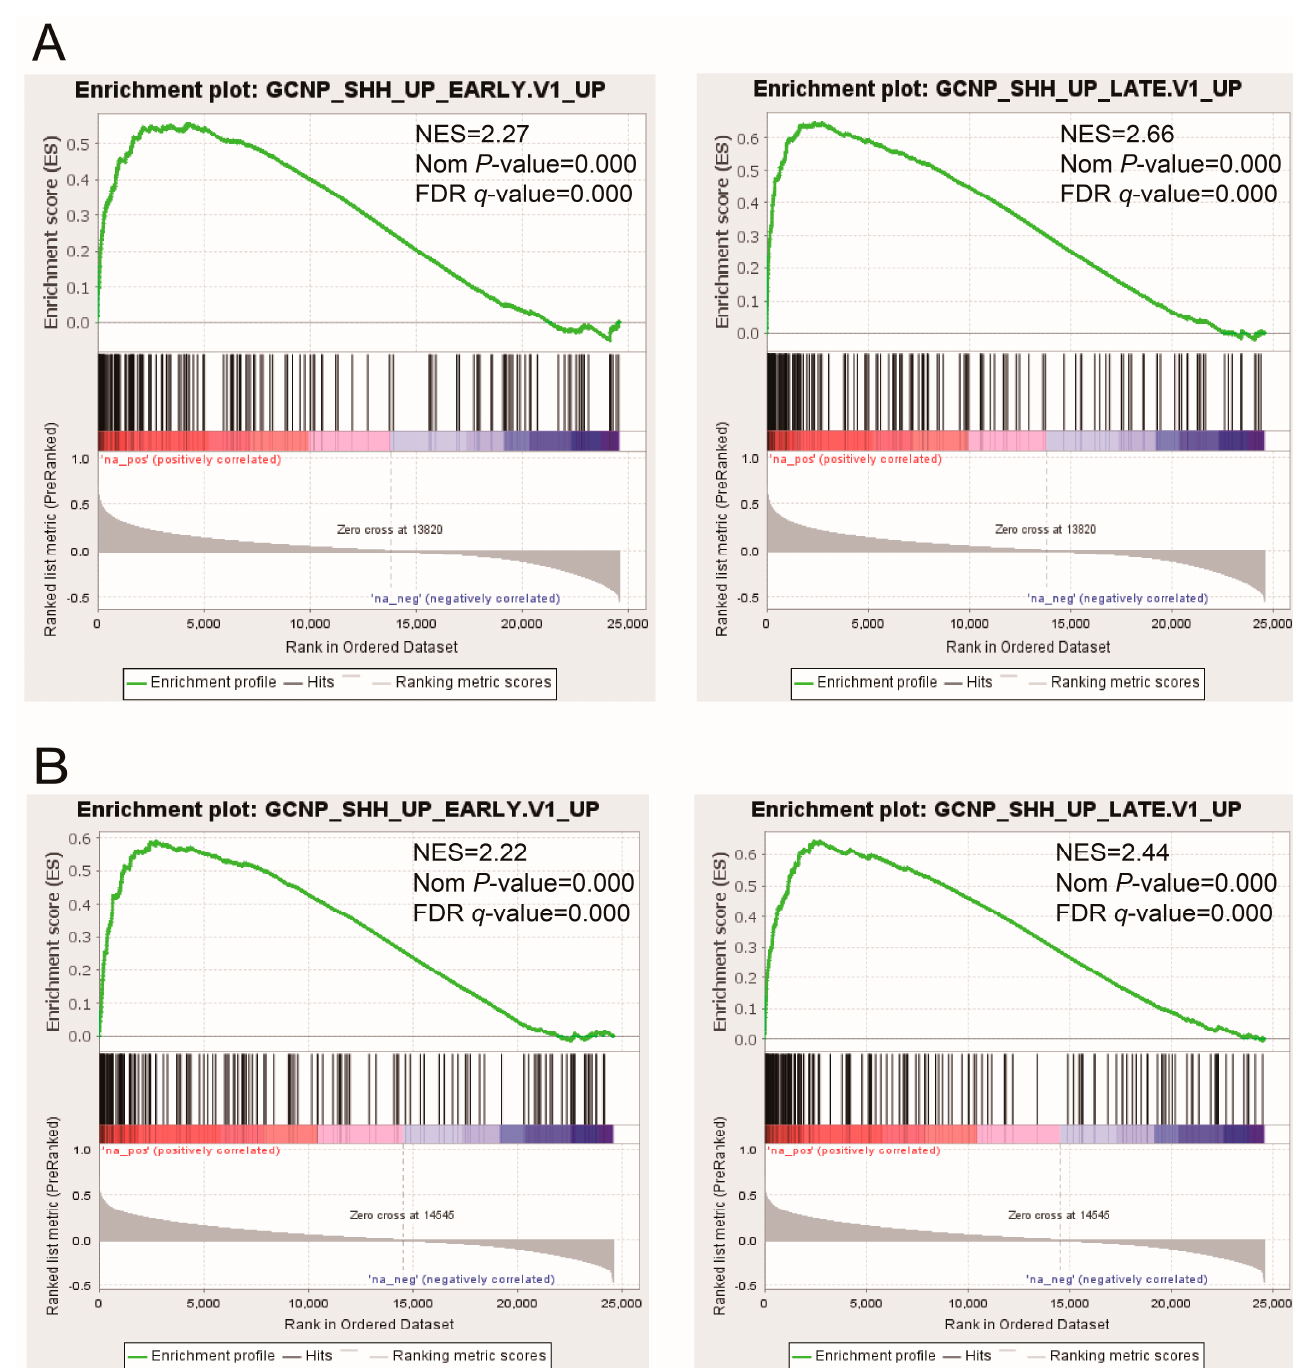
Figure 2. GSEA of the PRR11-SKA2 correlated gene set in the LSCC cohort of TCGA. ‘GCNP_SHH_UP_EARLY.V1_UP’ and ‘GCNP_SHH_UP_LATE.V1_UP’ gene sets were enriched in both the PRR11 positively correlated gene list ( A ) and the SKA2 positively correlated gene list ( B ). The normalized enrichment score (NES), the nominal p -value, and the false discovery rate (FDR) were calculated for each gene set. Nominal p -value < 0.05 and FDR q -value < 0.05 were taken to be statistically significant.